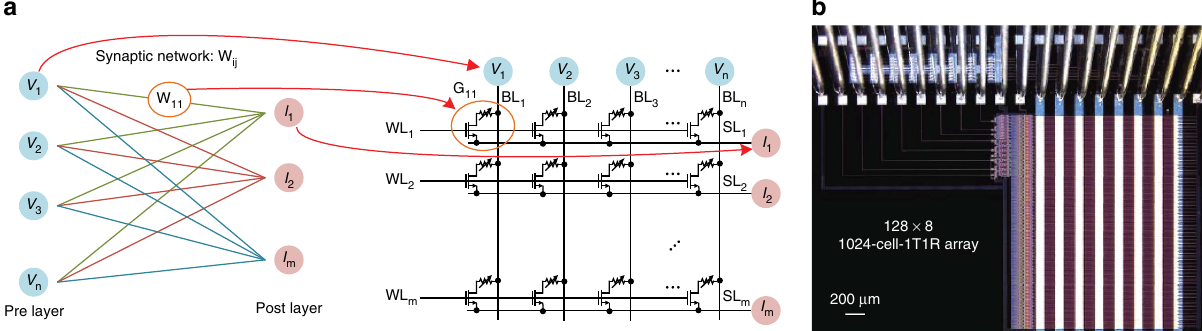
Figure 1 | The 1T1R architecture and the 1024-cell-1T1R array. ( a ) Mapping of a one-layer neural network on the 1T1R array, that is, the input of preneuron layer, adaptable synaptic weight and weighted sum output of postneuron layer maps to the pulse input from BL, cell conductance and current output through SL, respectively. In 1T1R, ‘T’ represents transistor, ‘R’ represents RRAM. ( b ) The micrograph of a fabricated 1024-cell-1T1R array using fully CMOS compatible fabrication